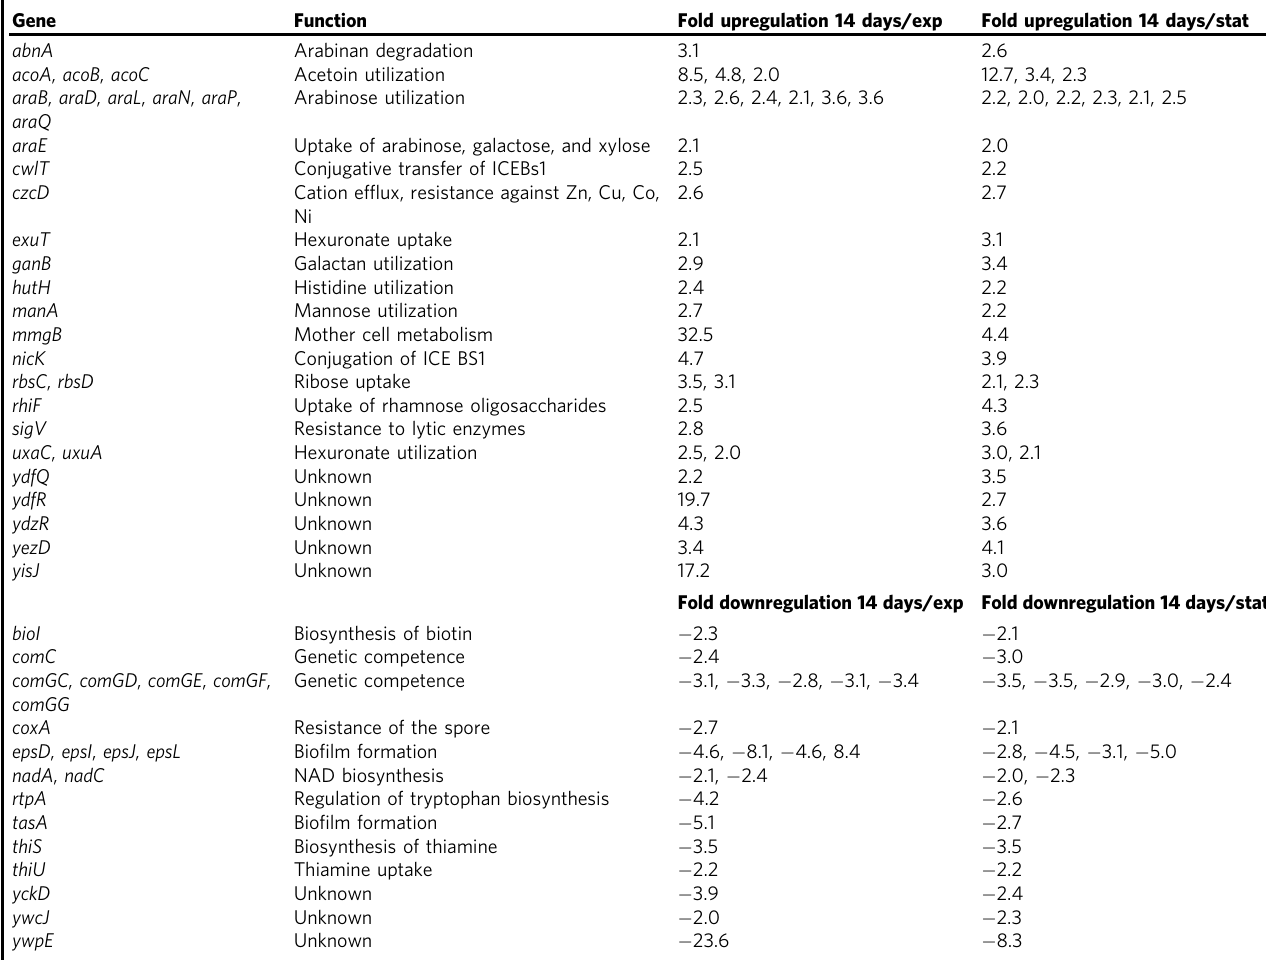
Table 1 Up- and downregulated genes in 14-day-starved cells